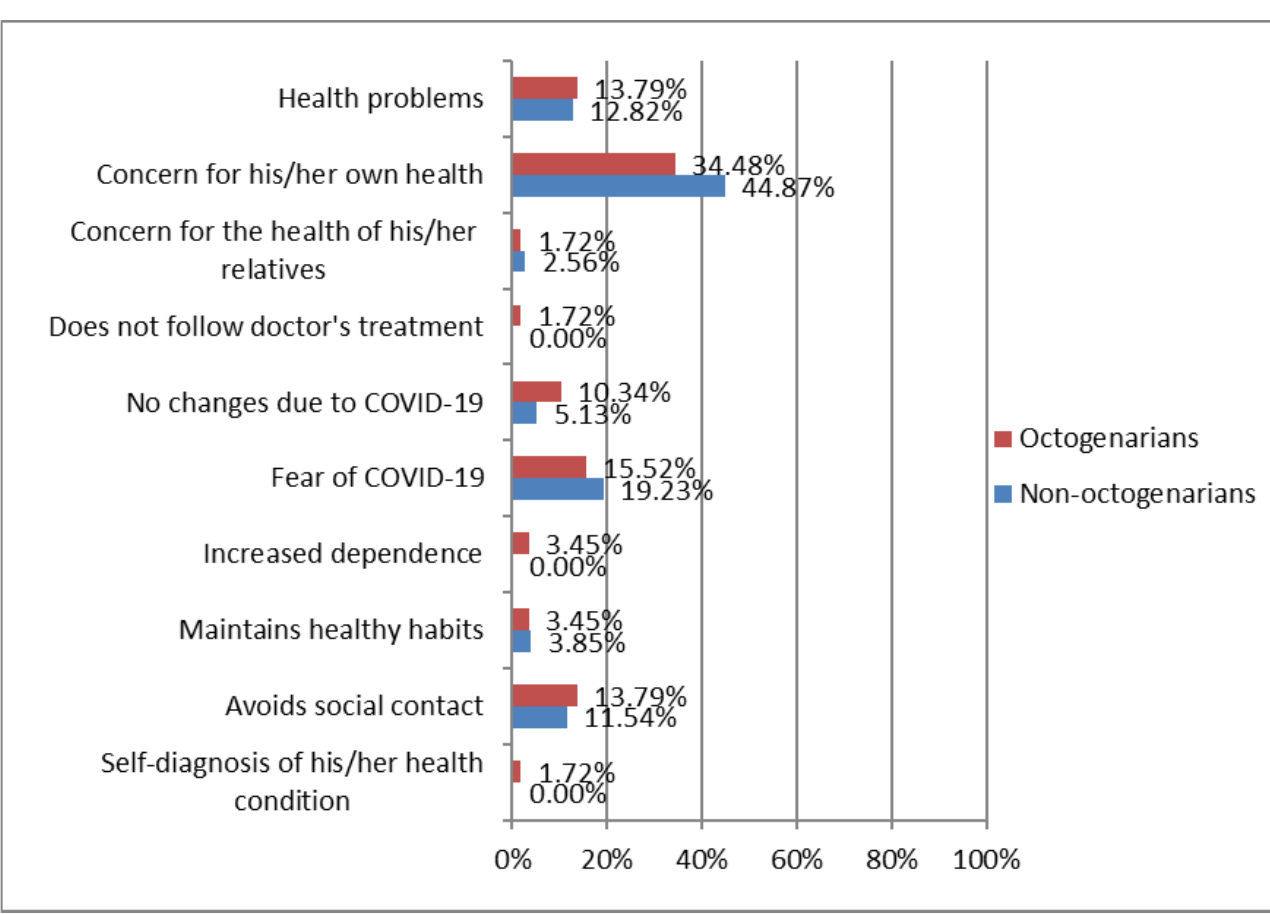
Figure 3. Differences between octogenarians vs. non-octogenarians in attention to heart failure symptoms during COVID-19 confinement. Octogenarians (≥80 years; n = 53). Non-octogenarians (<80 years; n = 67).